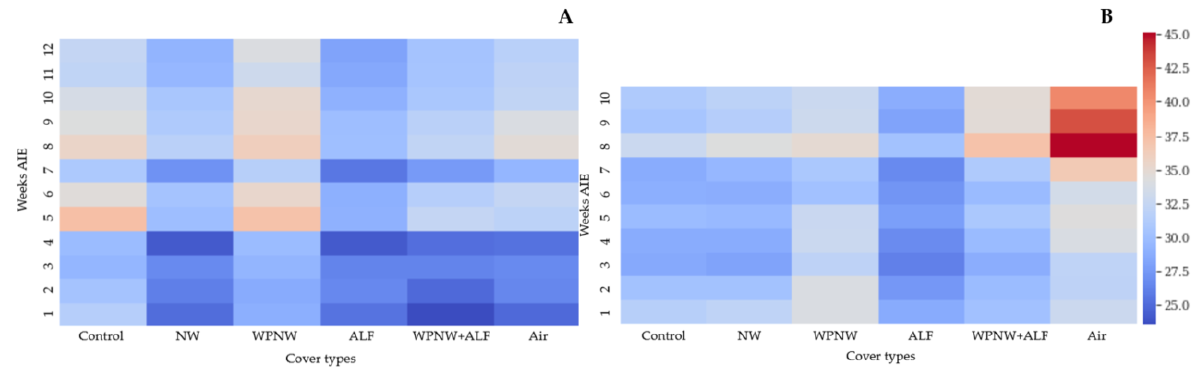
Figure 4. Heatmap chart of average maximum temperature during the weeks after inflorescence emergence (AIE) for the winter (12 weeks AIE) ( A ) and summer (10 weeks AIE) ( B ) trials. Red and blue colors represent high temperature and low temperature levels, respectively.